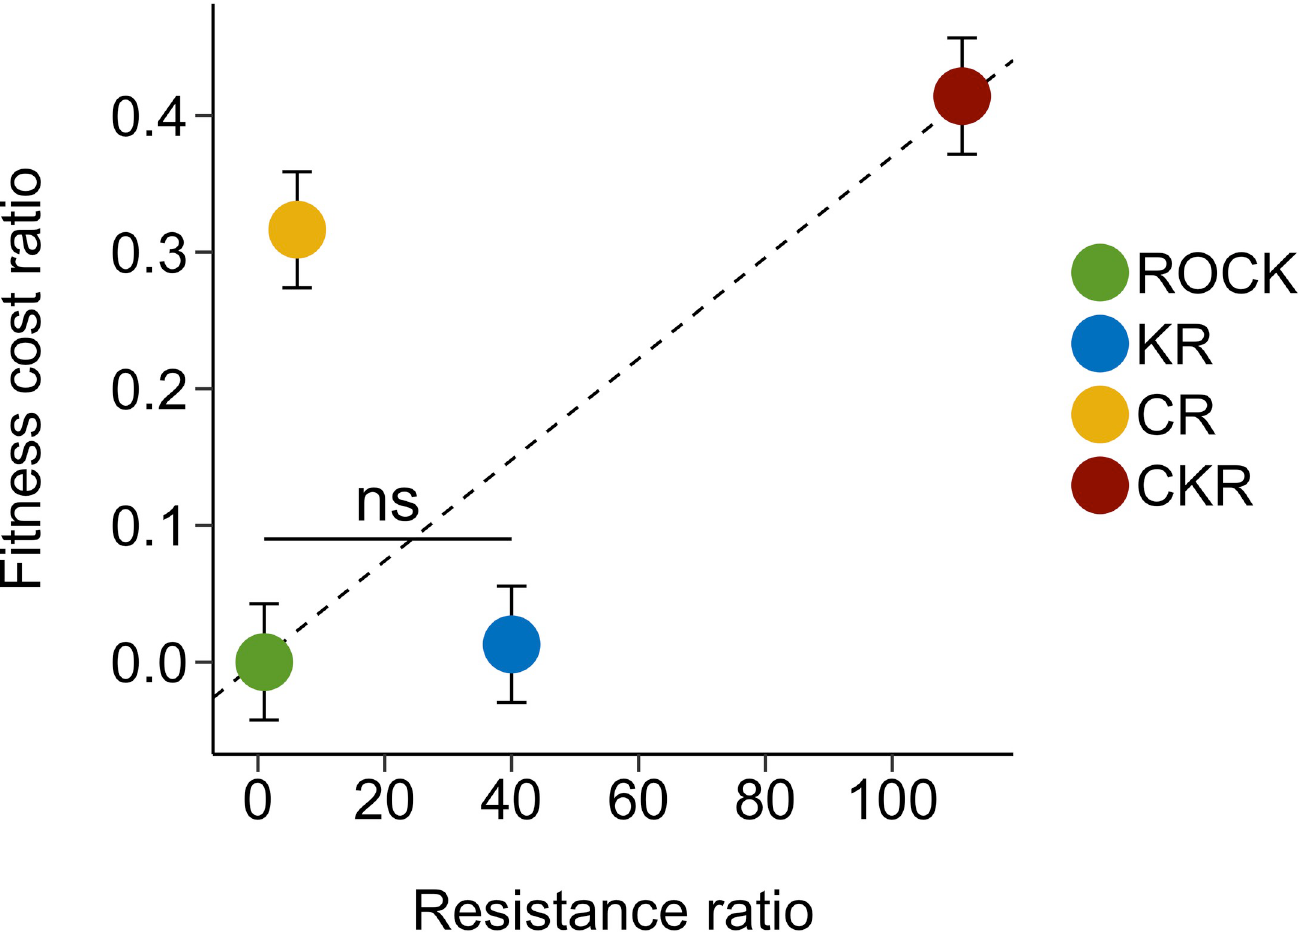
Fig 5. Relationship between fitness cost ratio and resistance ratio. Dashed line represents a linear relationship between fitness cost ratio and resistance ratio. Fitness ratio values are significantly different (p < 0.05) except for where labeled as “ns” (not significantly different). Bars represent the standard error of the means. Resistance ratios are from previous publications